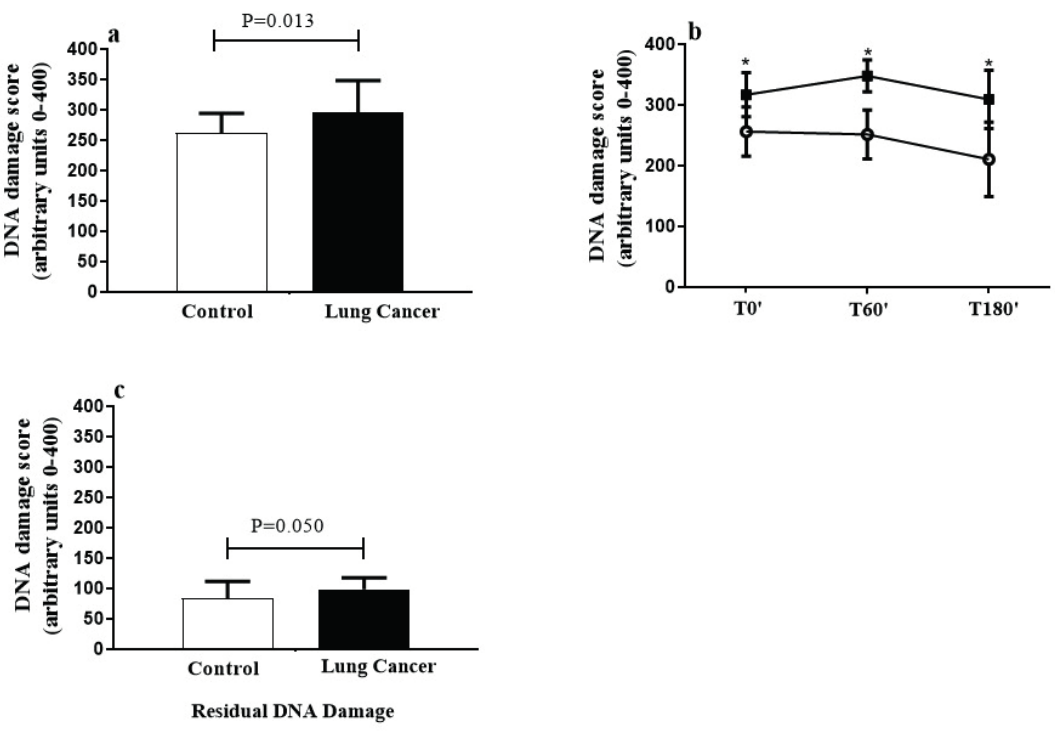
Figure 2 - DNA Damage Index and repair kinetics post-incubation with methyl methanesulfonate in the CO and CA groups through the comet assay. a : Frequency of baseline damage index; b : repair kinetics: frequency of DNA damage index at different times [time zero (t0’) *P < 0.050; time 60 minutes (t60’) *P < 0.050; time 180 minutes (t180’) *P < 0.050 post-incubation with MMS; c : Frequency of residual damage after incubation with MMS. CO: control group; CA: group with lung cancer; Student’s t -test was performed to compare the alkaline damage index and the residual damage between the groups and the analysis of variance (ANOVA) test with tukey post-hoc.